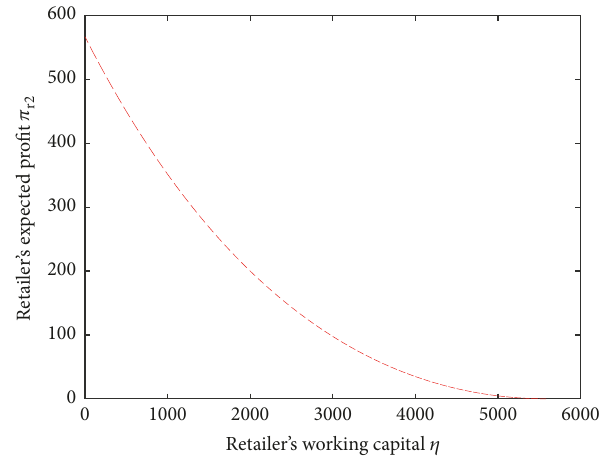
Figure 3: Change trend of retailer’s expected profit 𝜋 𝑟2 with retailer’s working capital 𝜂